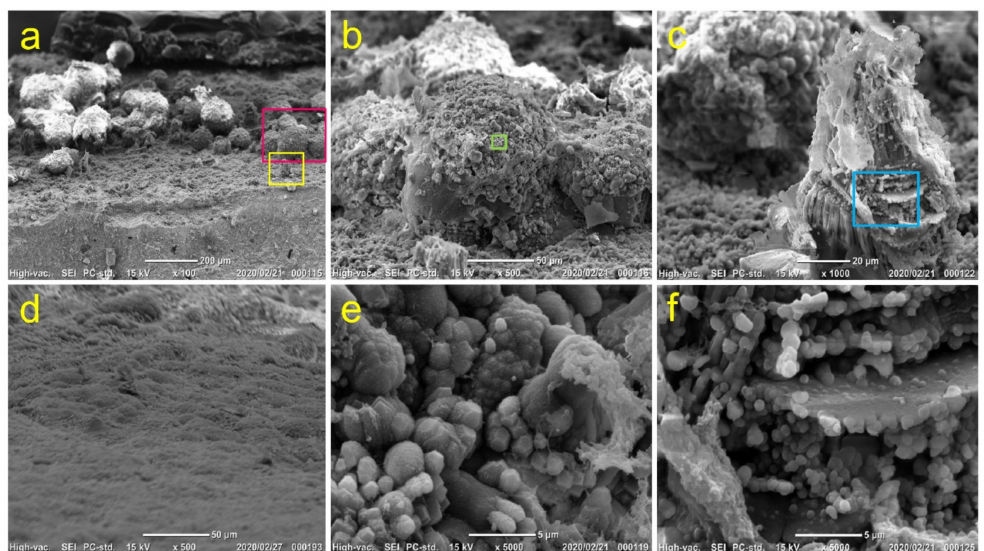
Figure 9. SEM observation of mineralized precipitates on MTA disks on Day 14 cultured in the presence of LDN-193189. ( a ) Surface of an MTA disk; high-magnification image of ( b ) red and ( c ) yellow boxed areas in ( a ); ( d ) MTA disk surface cultured without DsRed-PPU7 cells; high-magnification image of (e) green and ( f ) blue boxed areas in ( b ) and ( c ). (magnification: ( a ) 100 × , ( b , d ) 500 × , ( c ) 1000 × , ( e , f ) 5000 × ; scale bar: ( a ) 200, ( b , d ) 50, ( c ) 20 and ( e , f ) 5 µ